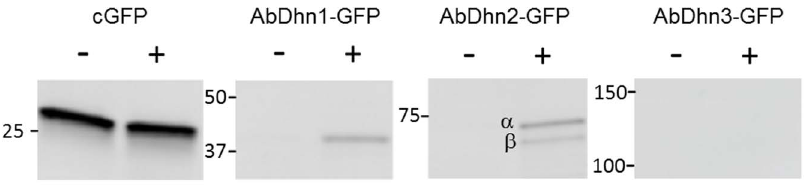
Figure 6. Expression of AbDhn-GFP proteins under salt stress. Germinated conidia (24 h-old) from strains expressing AbDhn-GFP fusions under the control of their own promoters or from a strain constitutively expressing GFP (cGFP) were either exposed to 350 mM NaCl for 2 h or left without stress. Proteins extracts were immunoblotted with HRP-coupled antibodies directed against GFP. Numbers correspond to molecular weights in kDa. The two AbDhn2 isoforms are indicated.